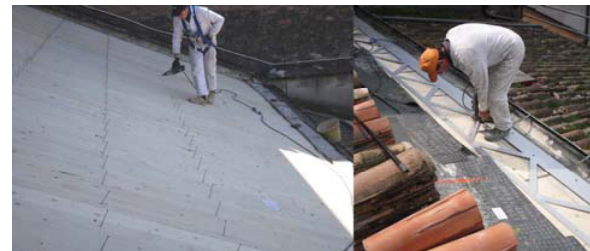
Figure 5: nailings of the wooden planking to the joists and securing the steel perimeter curb.